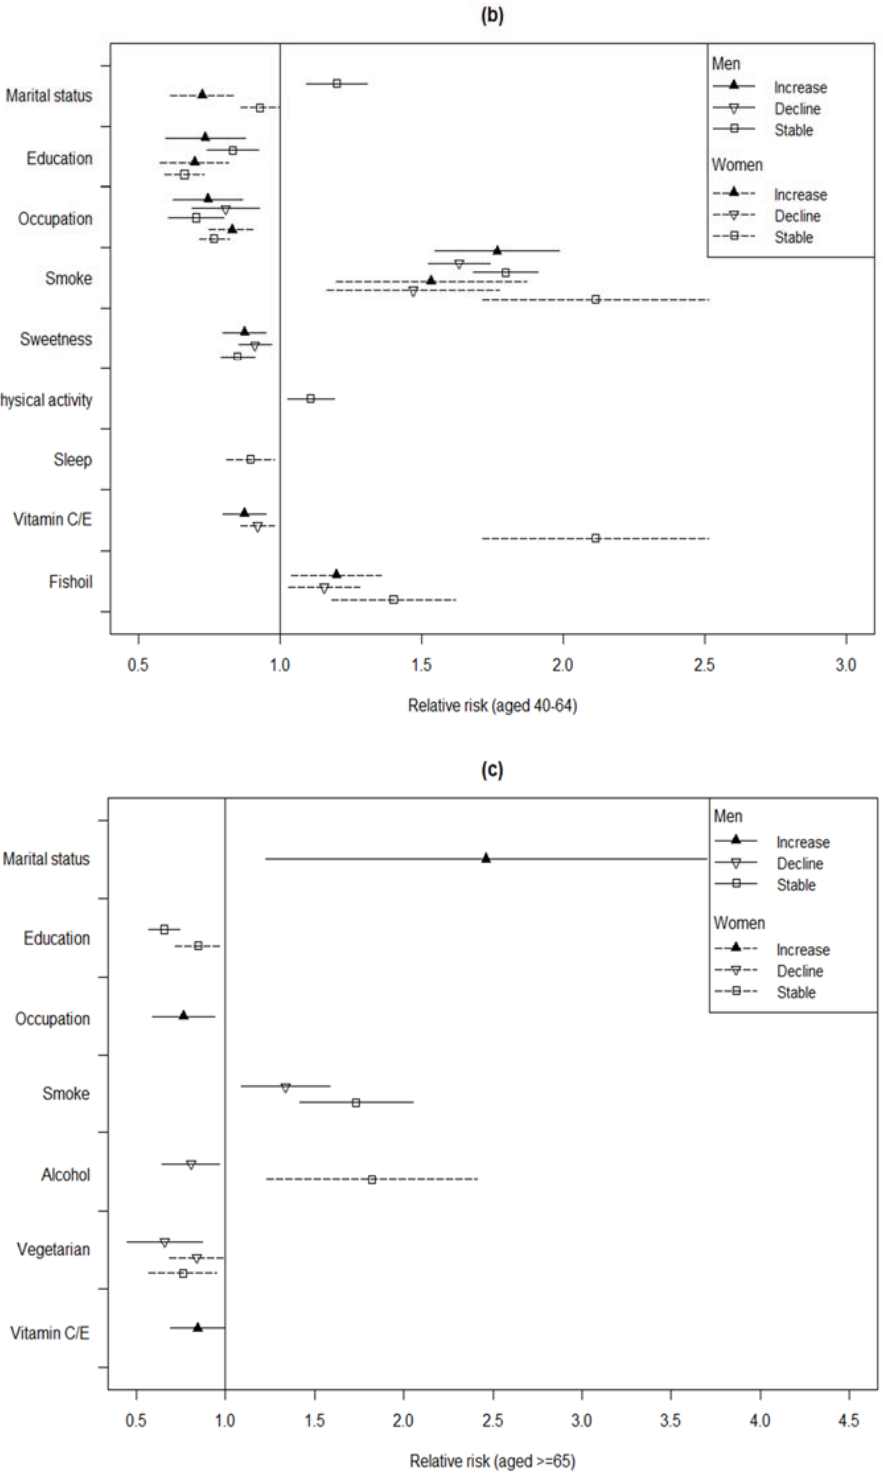
Figure 1. The relative risks (RRs) and 95% CIs of SES and lifestyle habits on 10-year Framingham risk score of cardiovascular disease (CVD) by sex- and age-stratified groups. Panel: ( a ) For subjects aged 20–39 years; ( b ) for subjects aged 40–64 years; ( c ) for aged ≥ 65 years. The statistics appropriate models were selected with Bayesian information criterion, based on the maximum likelihood method. Only RRs with significant values are shown, with these RRs being calculated by the GEE model adjusted with all covariates, including BMI and medicinal treatment. Each compared group (baseline) of explanatory variables was stable no/low status through the three study stages. The line presenting an increase, indicates the characteristic from absent to appear or the level from lower to higher, and vice versa.